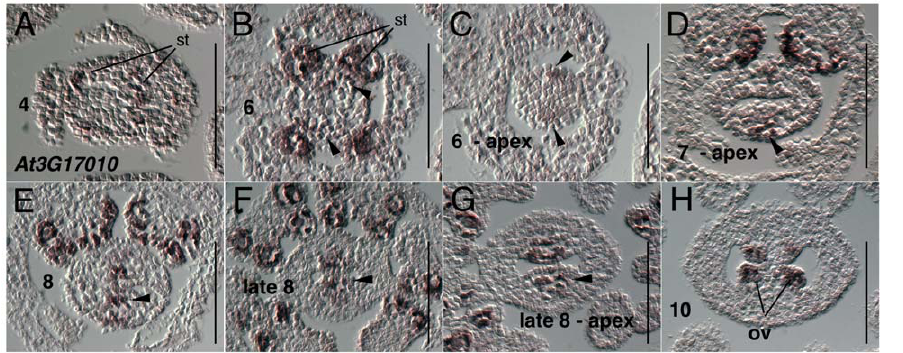
Figure 5. Results of insitu hybridization with AT3G17010 ( REM22 ) antisense probe. Numbers indicate floral stages. All panels show transverse (cross sectional) tissue orientation. Arrowheads indicate medial domain expression; ov - ovule; st- stamen primordia. Scale bars in all panels are 100 microns. All panels are Col-0 wild type tissue. Oblique section in panel B skews apparent location of medial domain slightly.